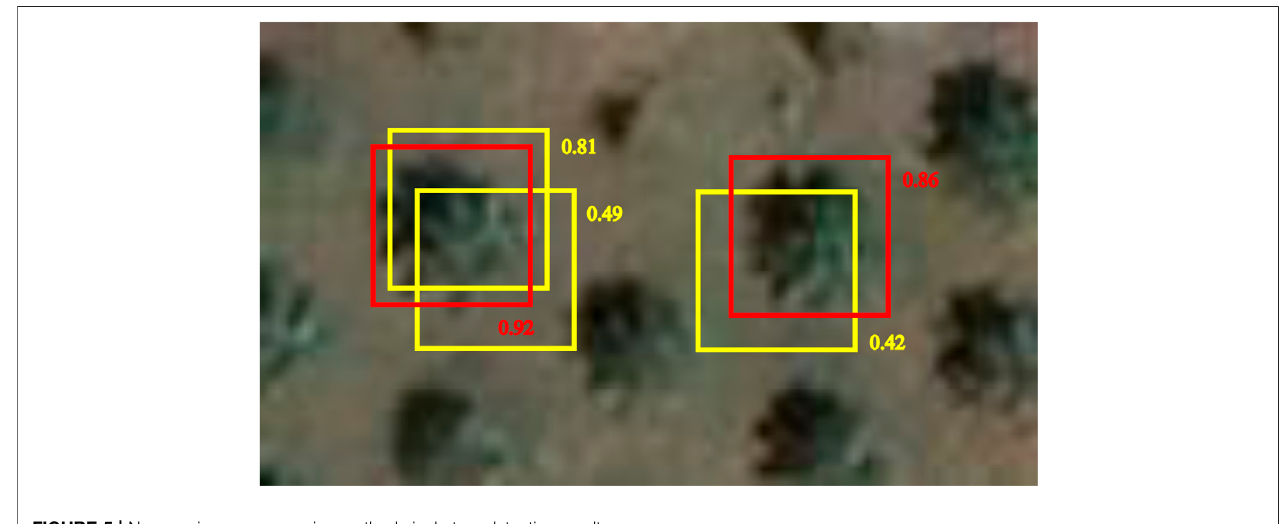
FIGURE 5 | Non-maximum suppression method single tree detection